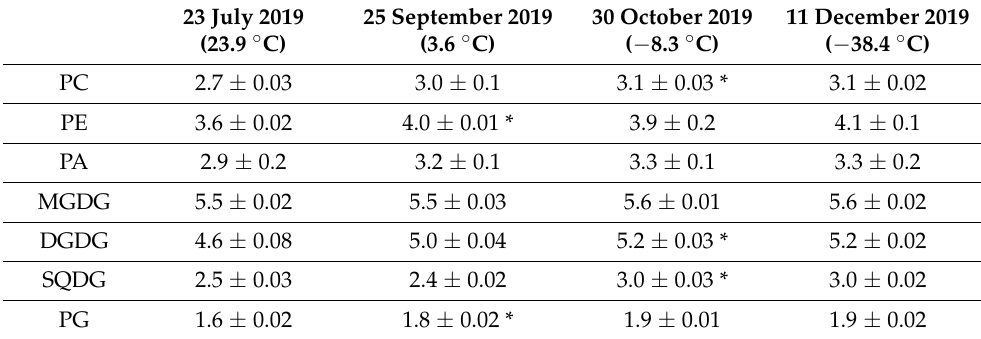
Table 4. Acyl chain length (ACL) of membrane lipids of Ephedra monosperma.